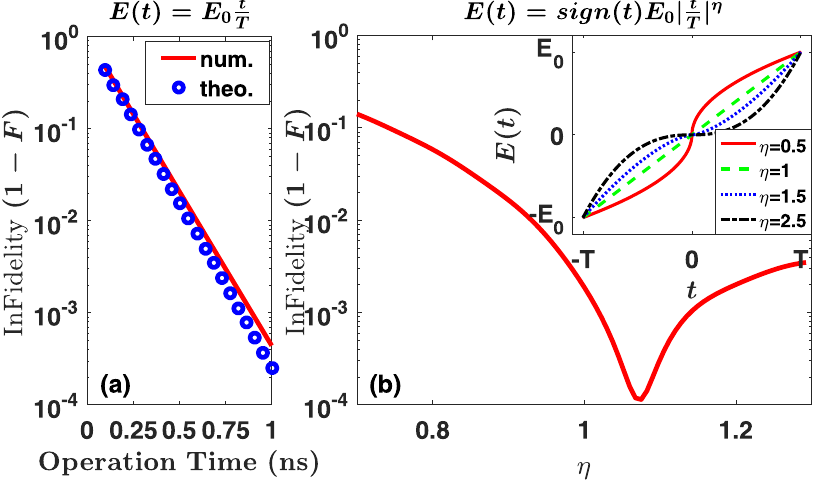
Figure 6. ( a ) Infidelity of spin transport as a function of the total operation time for a linear pulse = E t E ( ) t ( b ) Transport infidelity for different power-law exponents of the electric field pulse. The pulse shape is determined by the power η as in E ( t ) = E 0 sign( t )| t / T | η . For panel (b), the total operation time is fixed at 2 T = 0.8 ns. For both panels (a and b) E 0 = 4000 V/m, B = 1